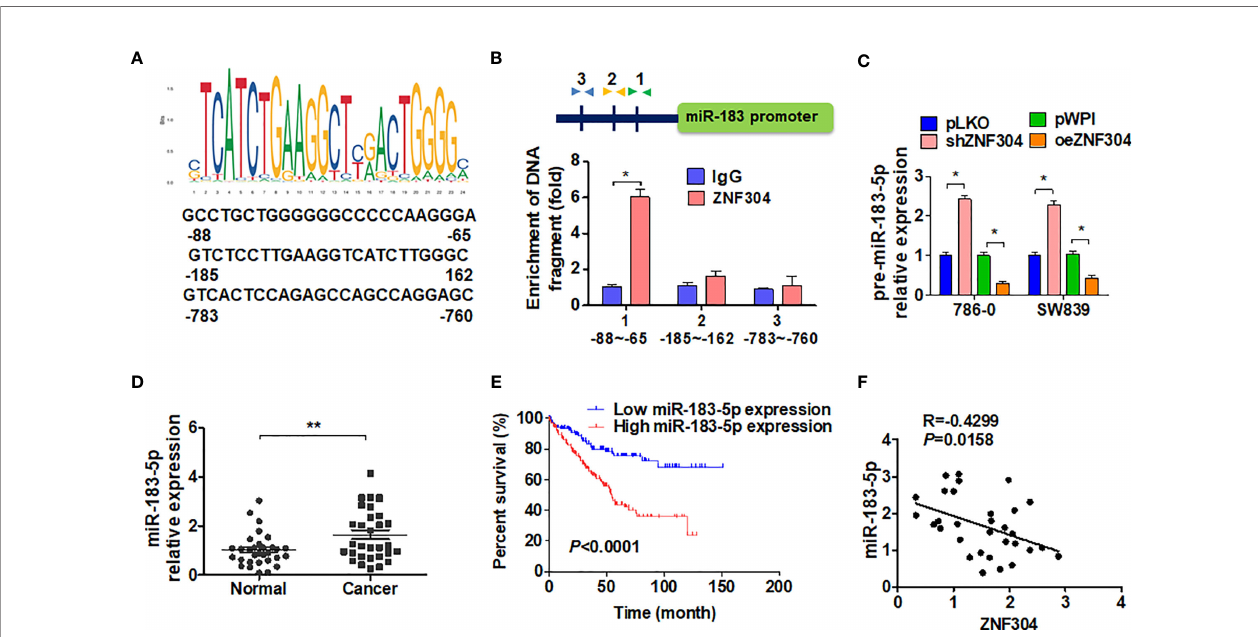
FIGURE 5 | ZNF304 downregulates miR-183-5p expression by transcriptional repression. (A) The level of miR-183-5p was detected by qRT-PCR in ccRCC (T, n = 43) and normal kidney (N, n = 43) tissues. (B) According to the expression level of miR-183-5p in the TCGA database, kaplan-Meier was used to analyze the overall survival of ccRCC patients (cutoff value is 25%). (C) Pearson correlation analysis ZNF304 and miR-183-5p correlation (R = 0.4299, P = 0.0158). (D) JASPAR (http:// jaspar.genereg.net/) predicted the potential binding site for ZNF304 in the miR-183-5p promotor. (E) Binding site of ZNF304 in miR-183-5p promoter region was con fi rmed by using ChIP-qPCR in 786-0 cell. The position of the primer is indicated by the arrowheads. (F) 786-0 and SW839 cells were transfected with oeZNF304 or shZNF304 or control vectors, and pre-miR-183-5p expression was measured by RT-qPCR. All data are from three independent experiments and expressed as the mean ± SEM. *P < 0.05, **P < 0.01 vs. the corresponding